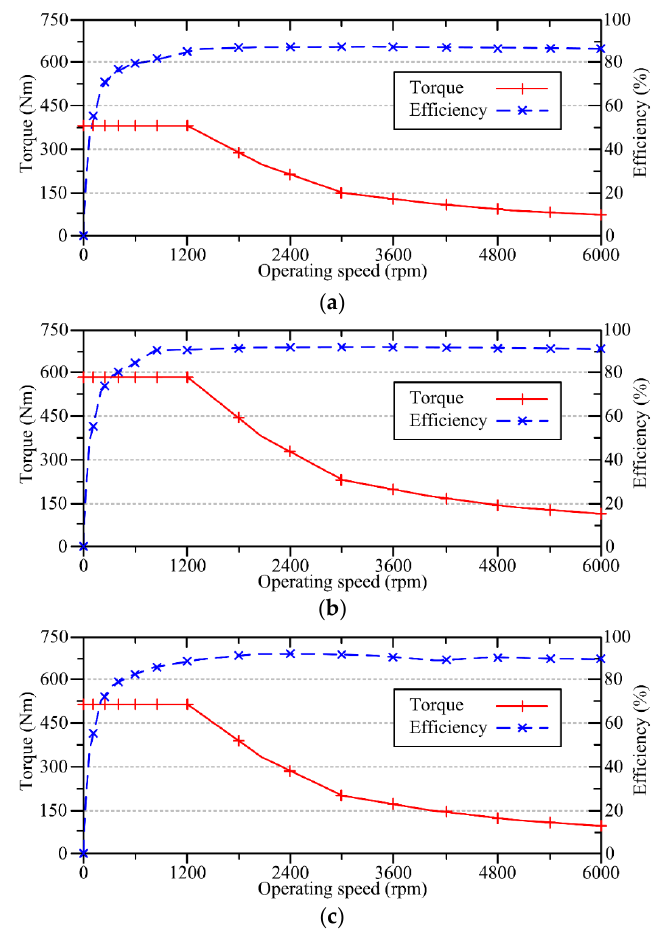
Figure 10. Torque capabilities and efficiencies against operating speeds: ( a ) IR-VPM; ( b ) OR-VPM and ( c ) OR-CP-VPM.